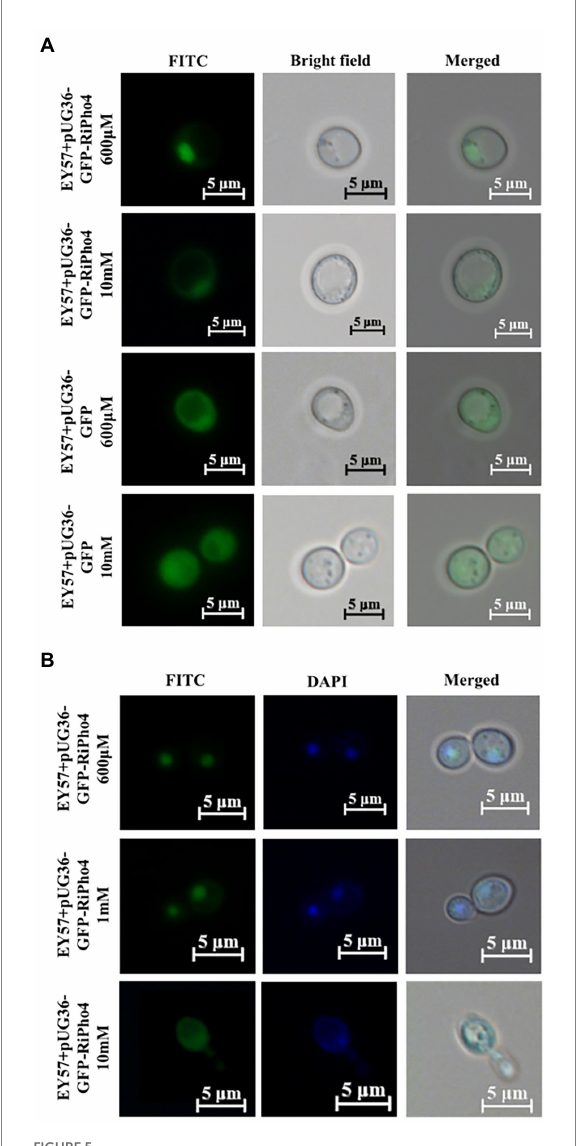
FIGURE 5 Subcellular localization of RiPho4 in Saccharomyces cerevisiae grown under different phosphate conditions. Fluorescence microscope images of S. cerevisiae EY57 cells expressing pUG36- GFP or pUG36-GFP-RiPho4. (A) Localization of RiPho4 was captured by fluorescence microscopy, the pUG36 containing the GFP reporter gene was used as the control, showing the fluorescence signal in the cytoplasm. The yeast cells were grown in YNB liquid medium with different Pi (600 μ M, 10 mM KH 2 PO 4 ) treatments for 12 h. (B) The transformed cells were grown in YNB medium under different Pi (600 μ M, 1 mM, 10 mM K 2 HPO 4 ) conditions for 12 h. FITC showed the green fluorescence channel; DAPI presented transformed yeast cells stained with DAPI dye. Scale bars, 5 μ